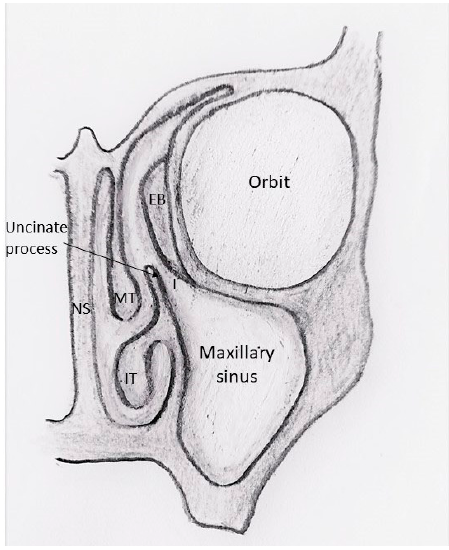
Figure 1. Anatomy of the ostiomeatal complex. MT = middle turbinate; IT = inferior turbinate; NS = nasal septum; I = infundibulum; EB = ethmoid bulla.